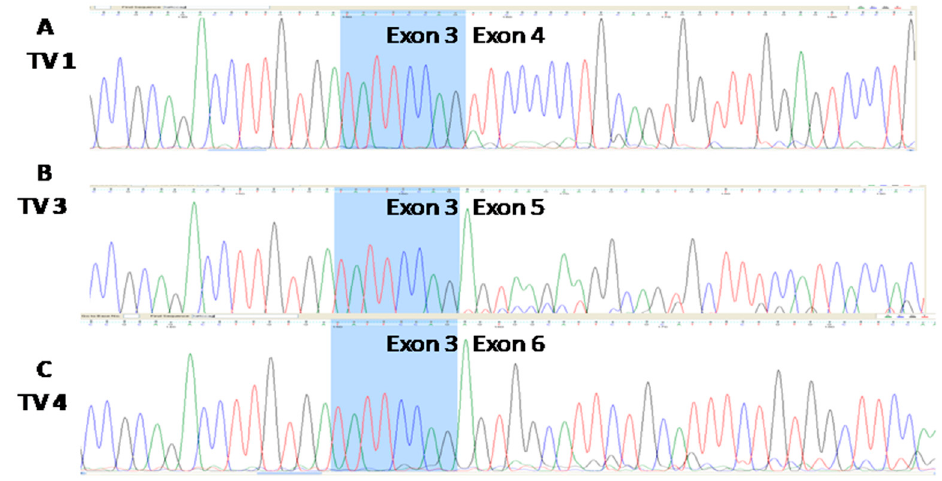
Figure 5. The sequence analyses of amplicons obtained from the Cal 27 NQO1-cDNA amplified with the primer pair NQO1F / NQO1R (Table 1), presented in Figure 4, confirm the presence of transcript variants TV1 ( A ), TV3 ( B ), and TV4 ( C ). Eight nucleotides in the terminal part of the 3' exon 3 are common to all three amplicons and are shown in blue. The sequences of TVs were identical in all cell lines.